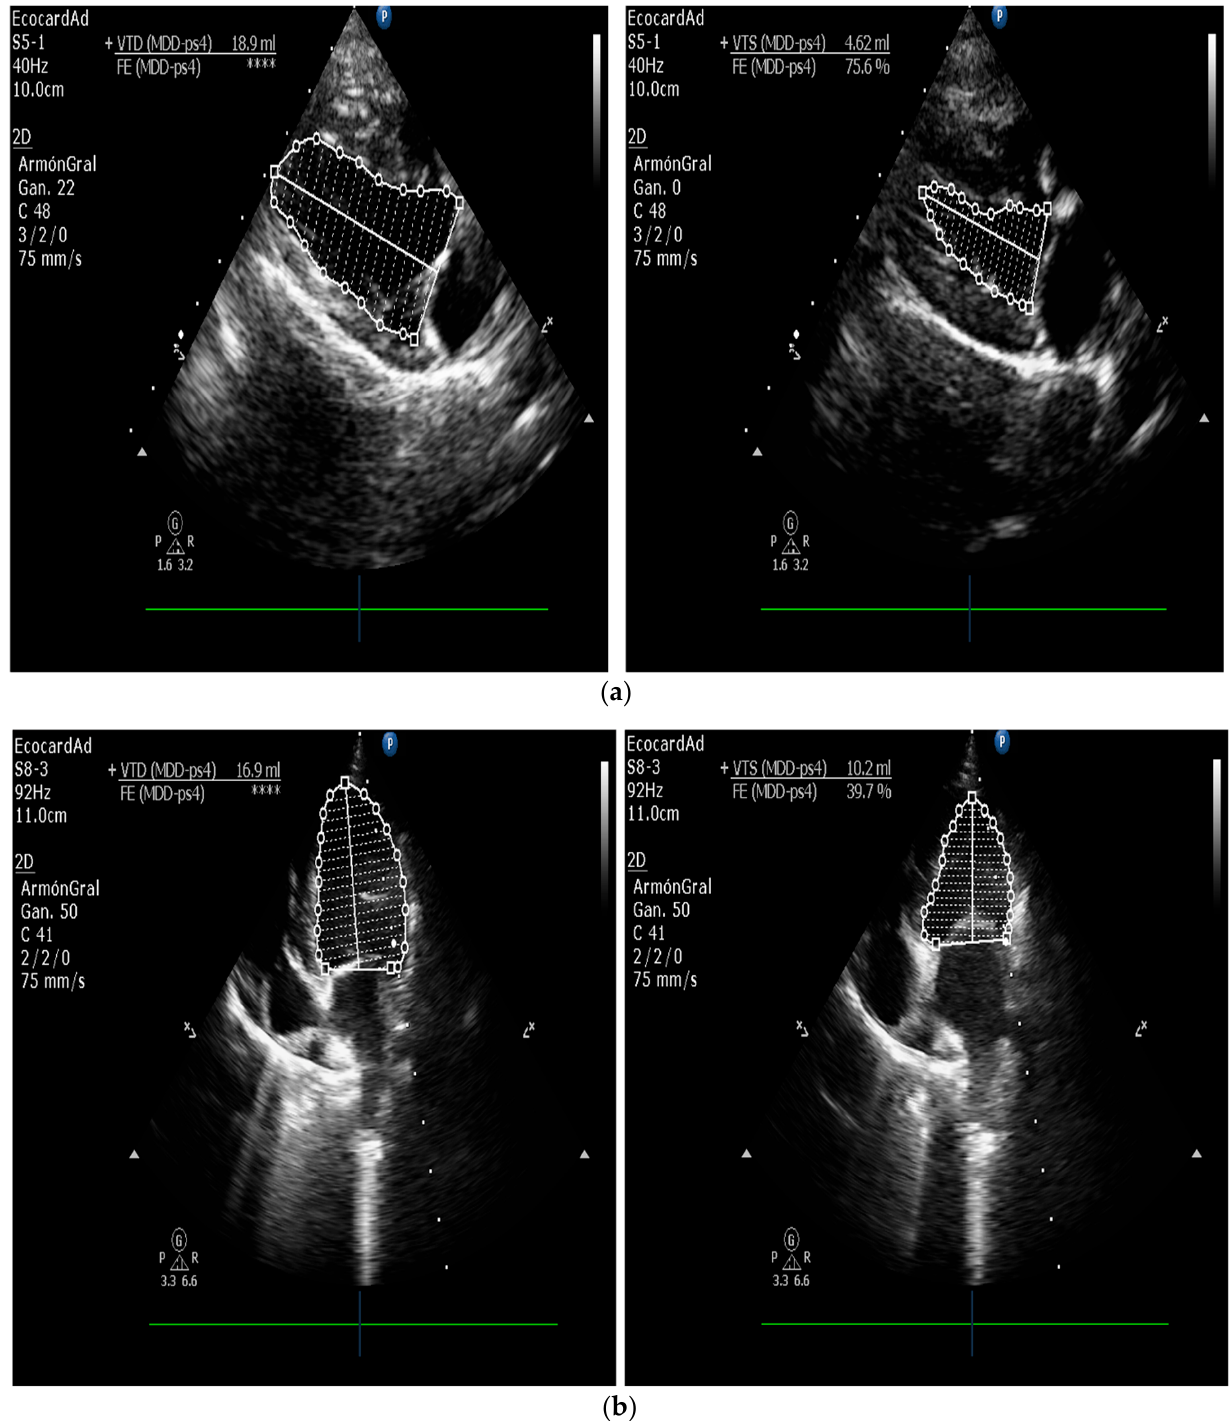
Figure 14. ( a , b ). Left ventricular volume by Simpson’s method of canine disk patient.